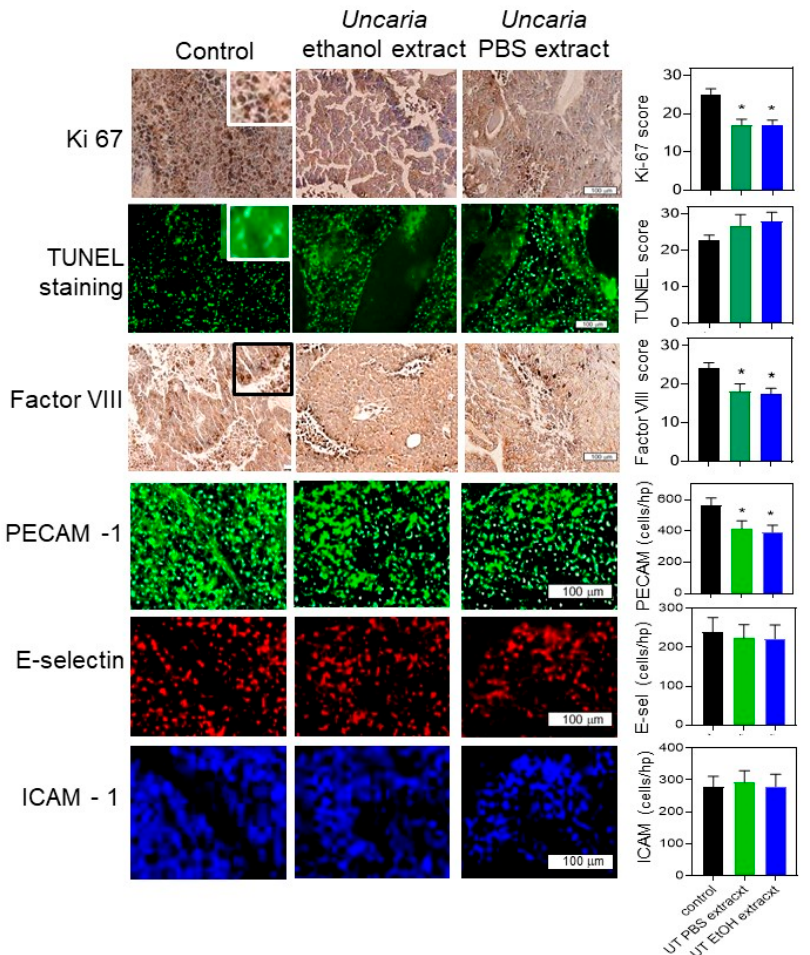
Figure 6. Histochemical analysis of cell viability and endothelial cell markers in sections of B16-BL6 tumours isolated from mice treated with Uncaria tomentosa extracts. Histochemical analysis was performed on B16-BL6 tumour tissue from mice treated with the vehicle, the resuspended ethanol extract, or the resuspended PBS extract of Uncaria tomentosa and typical microscopic fields shown. Sections were stained with the anti-Ki67 antibody, TUNEL reagent, or anti-Factor VIII antibody and the relative intensity of staining was determined from 8 images/tumour on an ordinal scale (0–5) directly from microscopic images. Inserts in the control images show higher magnification images of stained cells. A tissue section was triple-stained with fluorescence-labelled antibodies against the endothelial cell markers PECAM-1, E-selectin, and ICAM-1. The number of labelled cells was counted for each high-power field (hpf) from 8 different fields and the mean and standard deviation determined for each condition is shown in the bar graphs. One-way ANOVA and post hoc Tukey tests were performed to reveal any significant differences (*) in staining levels between tumours treated with Uncaria tomentosa extracts and vehicle only control tumours ( p < 0.05).